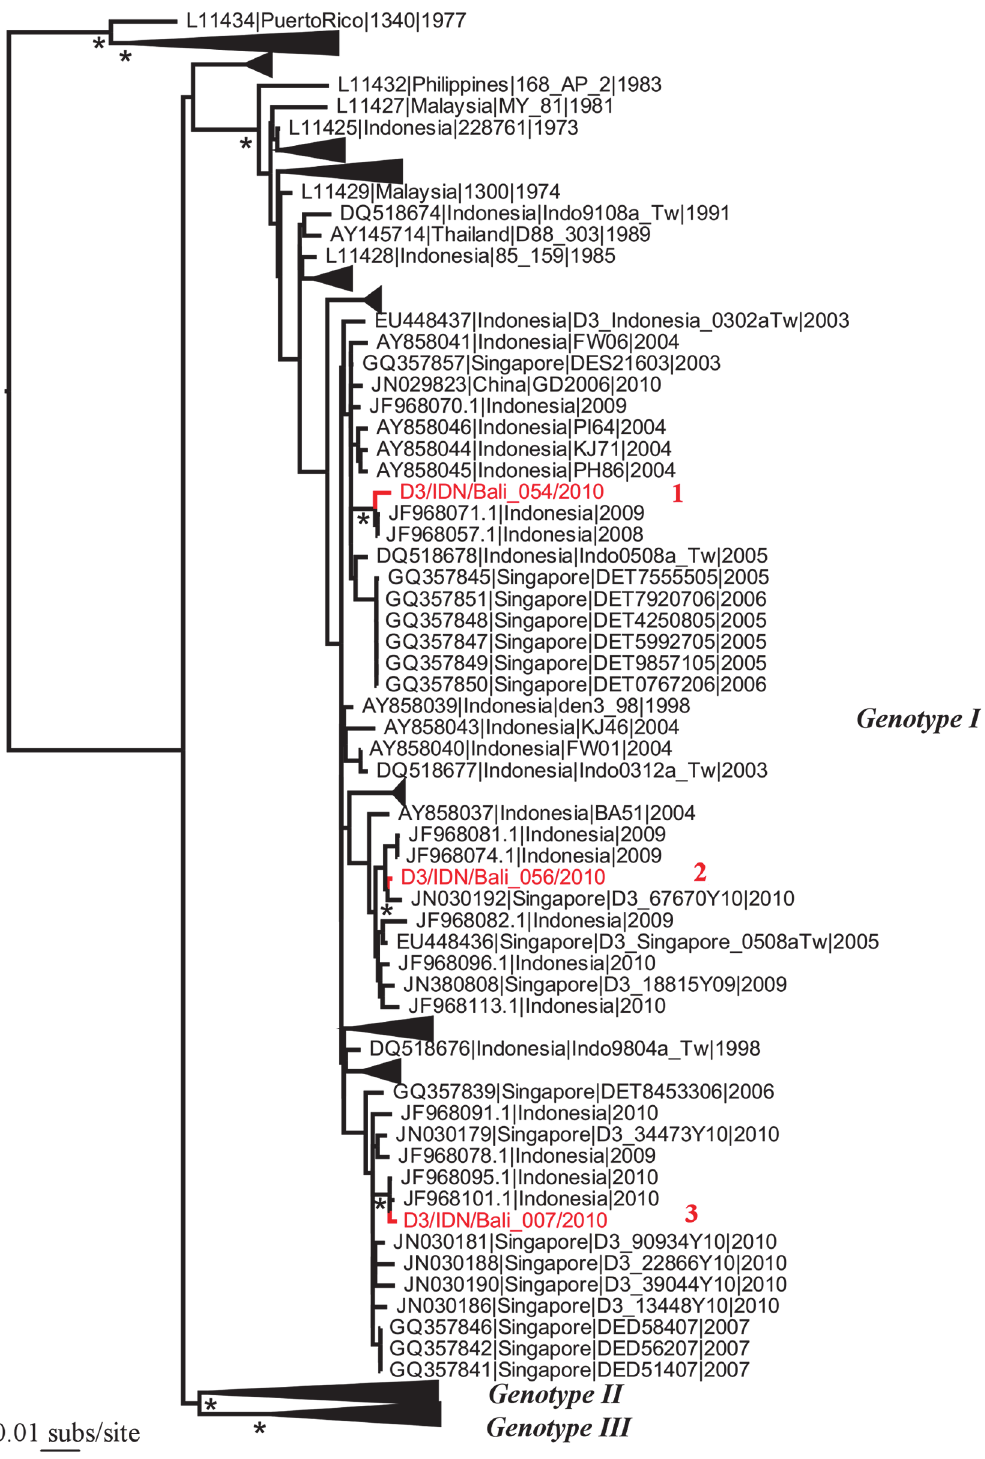
Figure 4. Phylogenetic tree of 1256 DENV-3 E sequences including three from travellers to Australia. Other features are as they are described in Fig. 2.